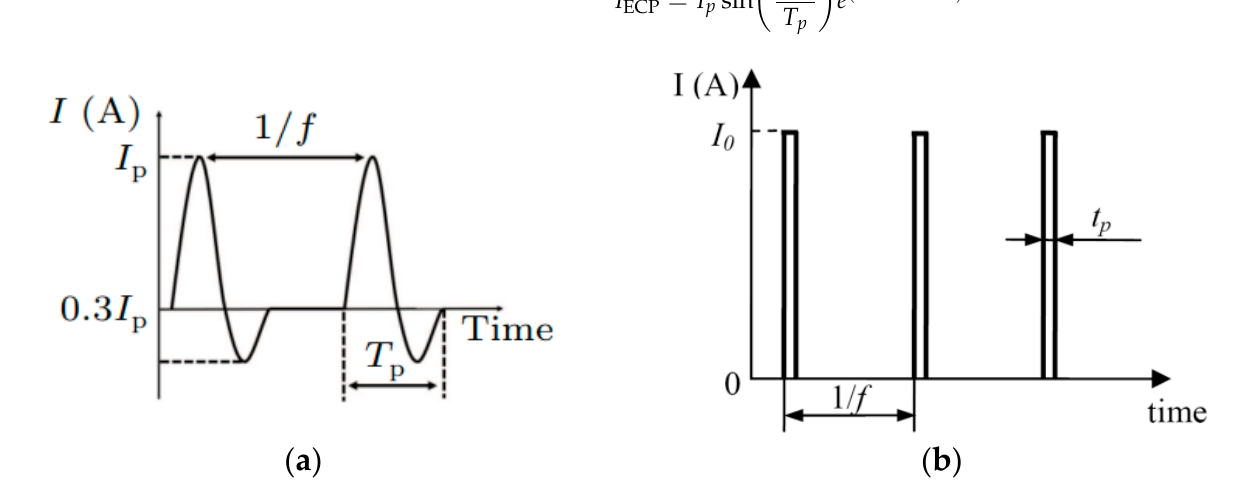
Figure 1. Schematic views of waveform of electric current pulse: ( a ) presented in work [1]; and ( b ) presented in the work [2].